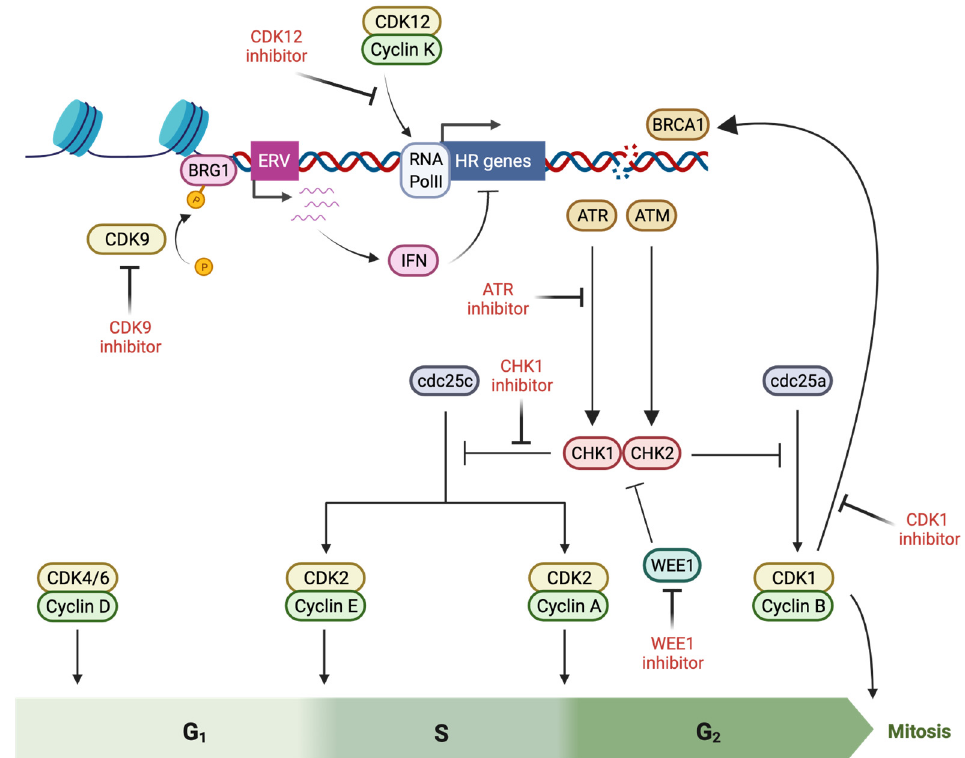
Figure 2. Induction of BRCAness by pharmacological targeting of cell cycle checkpoint proteins (created with Biorender.com, accessed 15 May 2022). Cell cycle arrest is initiated as a component of the response to DNA damage, initiated by activation of ATM (ataxia-telangiectasia mutated) and ATR (ataxia-telangiectasia and Rad3-related), which lead to CHK (checkpoint kinase) 2 and − 1 phosphorylation and Cdc25 antagonism, producing inhibitory phosphorylation of cyclin-dependent kinases (CDK) that prevents cell cycle progression. Multiple factors in this cell cycle checkpoint response directly interact with double strand break repair proteins, promoting repair activity–and thus offering a potential for BRCAness induction via inhibitory molecules.